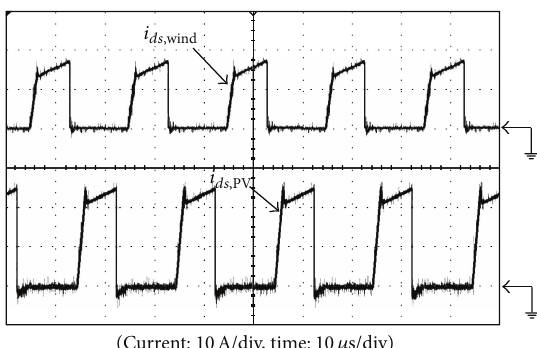
Figure 25: Measured current waveforms of the secondary windings in the MIC.